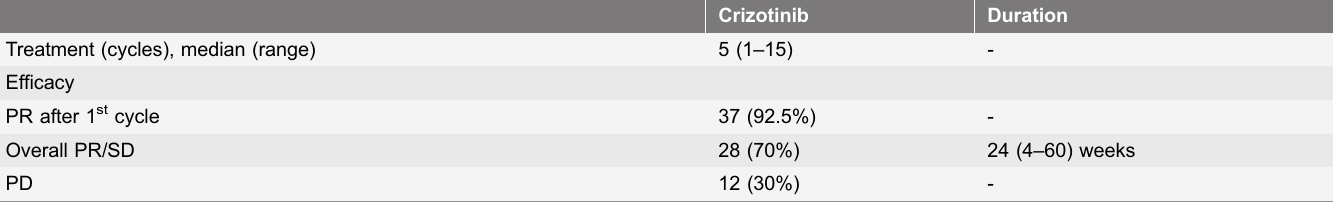
Table 2. Efficacy of 40 Chinese patients treated with crizotinib according to RECIST